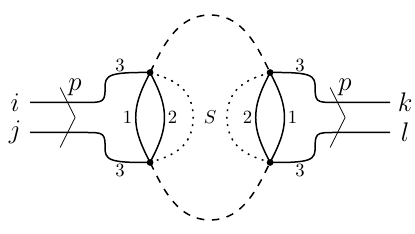
Figure 8 . One-loop self energy (cid:5) ij ; kl ( p ) of the intermediate matrix